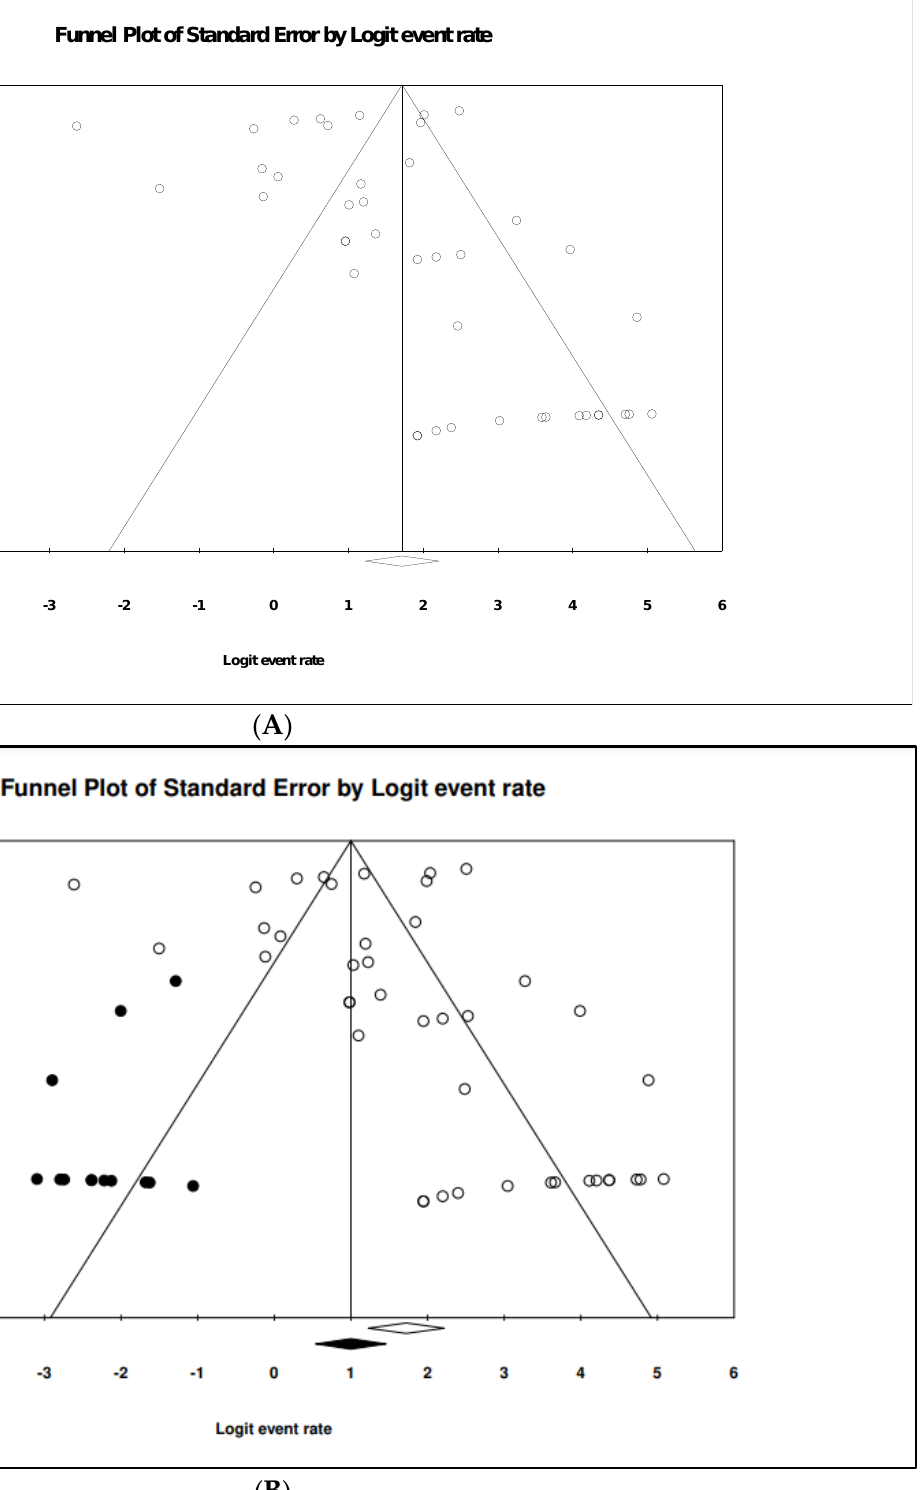
Figure 4. Funnel plot showing ( A ) publication bias in studies reporting the prevalence of antimicrobial resistant S. Typhi and ( B ) result after performing the trim-and-fill method where 13 missing studies (closed circles) were added on the left side of the mean effect.